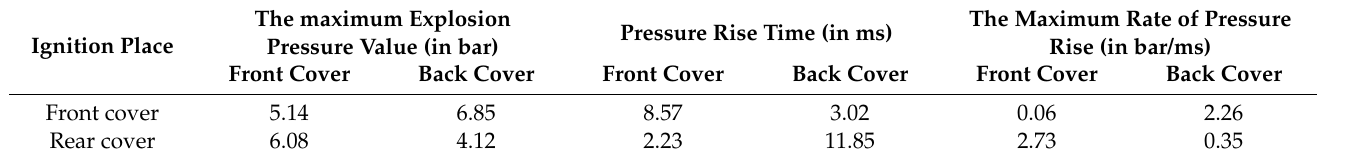
Table 4. Explosion pressure parameters of sample 2.